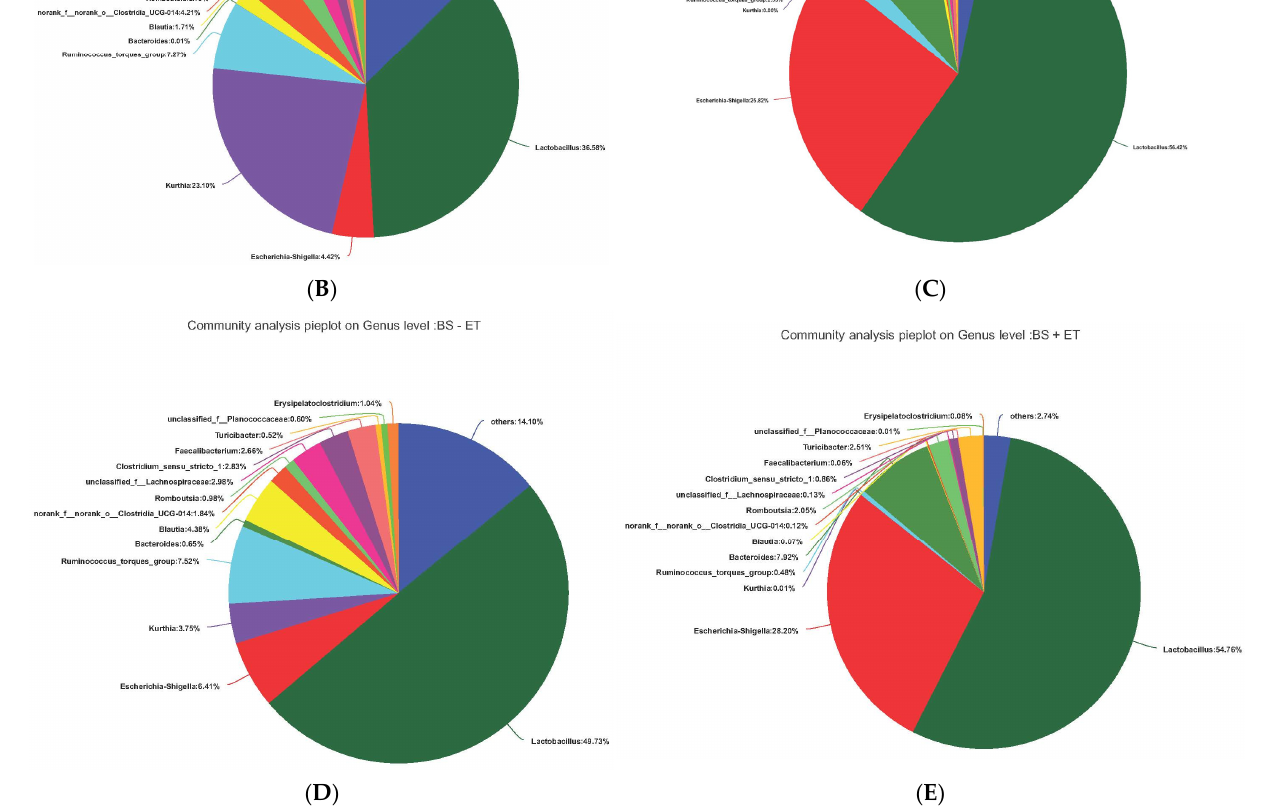
Figure 4. Relative abundances of the taxa at genus level. ( A ) Relative abundances of the affected taxa at genus level among all groups. ( B ) Total affected percentage of each genus in group CG − ET. ( C ) Total affected percentage of each genus in group CG + ET. ( D ) Total affected percentage of each genus in group BS − ET. ( E ) Total affected percentage of each genus in group BS +